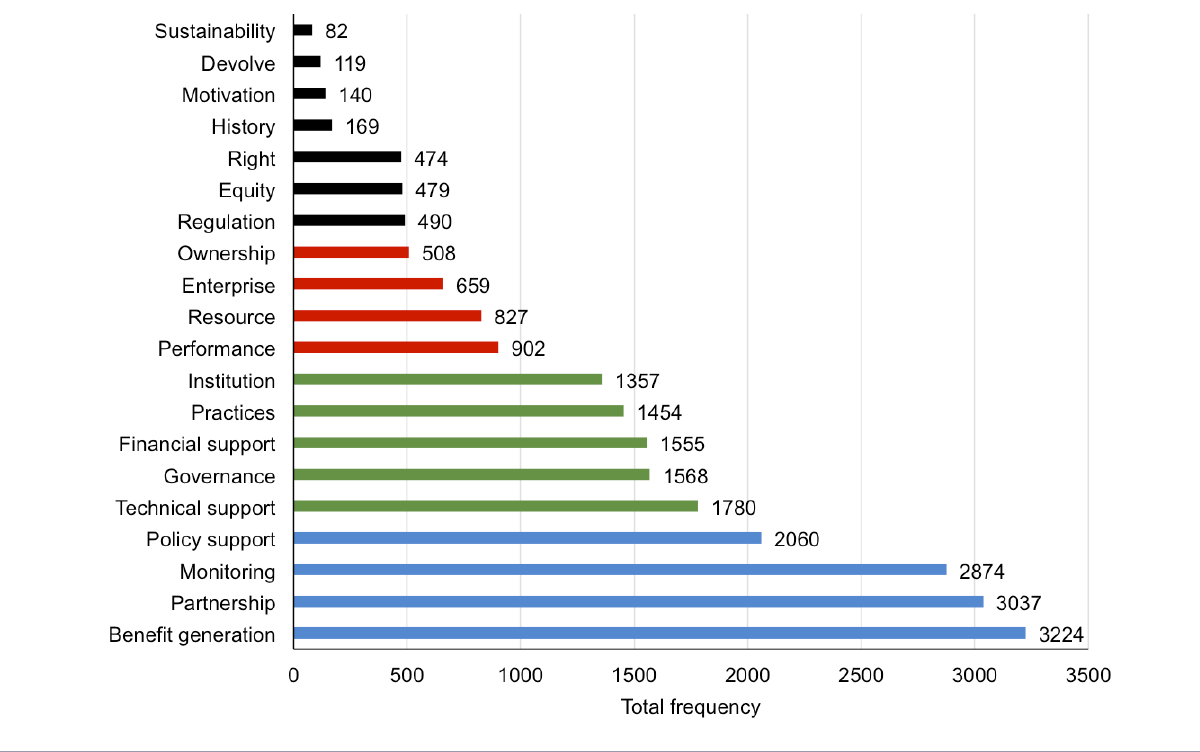
Fig. 3 . Frequency based analysis of enablers selected for the analysis. Note the different colors show the five distinct clusters based on cumulative